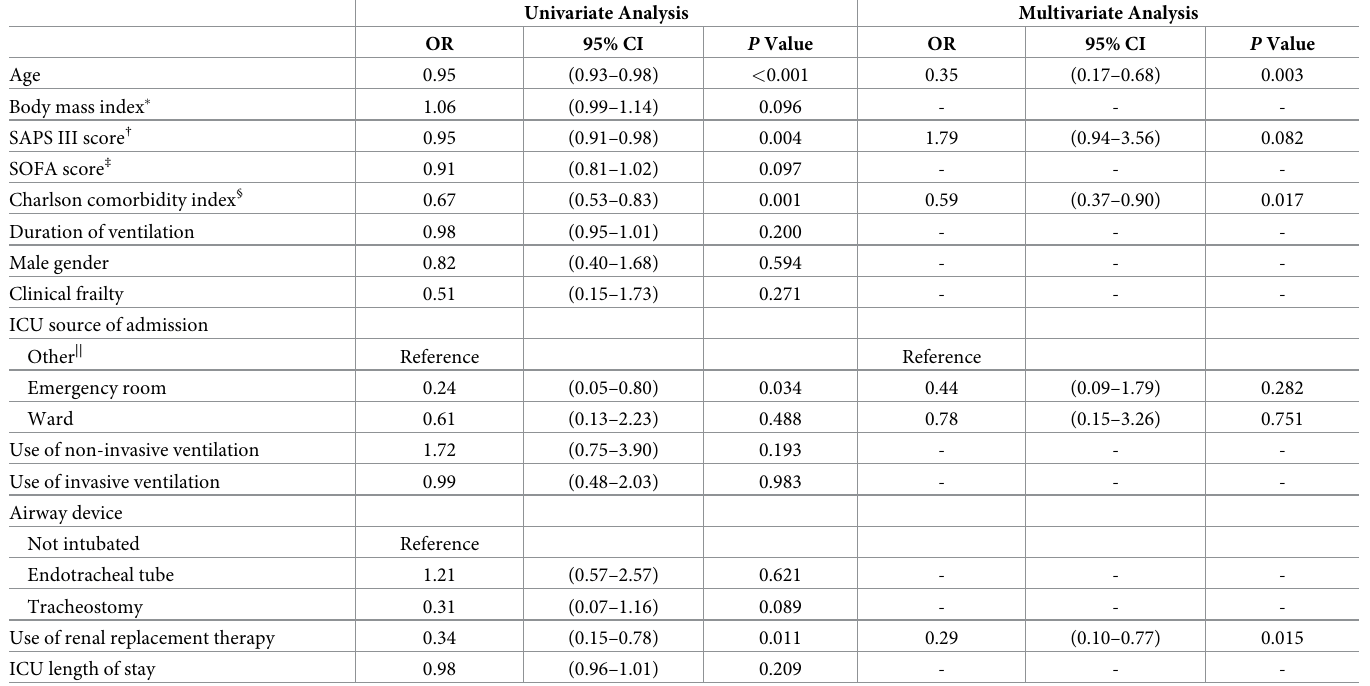
Table 3. Univariable and multivariate logistic regression analysis addressing risk factors associated with patients’ mobility level (n = 136